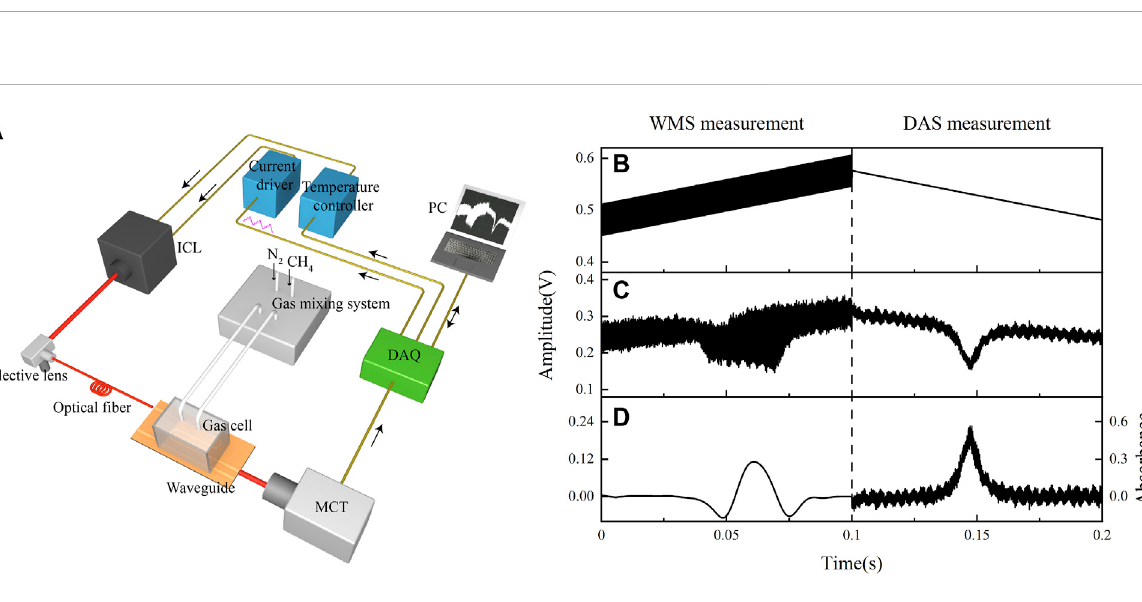
FIGURE 2 (A) Schematic of the SOI waveguide sensor system. (B) Driving signal of the ICL. For the rising edge, a ramp signal is superimposed with a high- frequency sine wave signal for WMS measurement. For the falling edge, only a ramp signal is used for DAS measurement. (C) The output